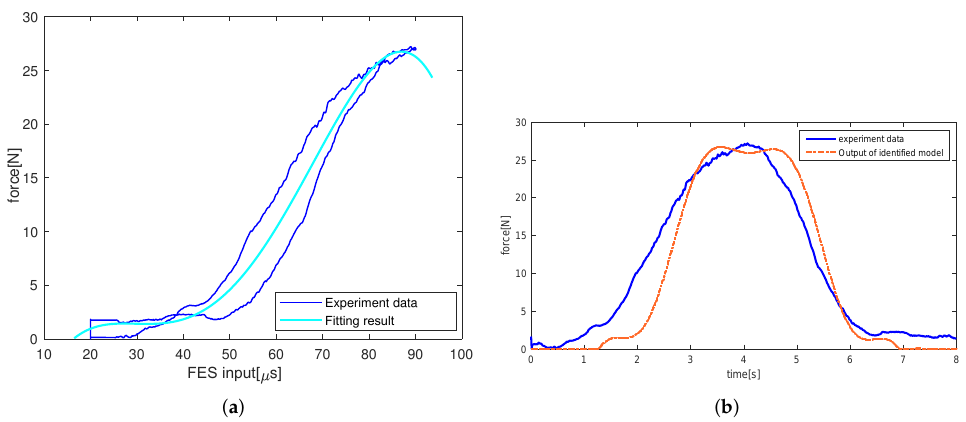
Figure 8. Model parameters Identification results. ( a ) Sinusoidal response data and the fitted nonlinear mapping function. ( b ) Experiment data and output force of identified model with the same control input.